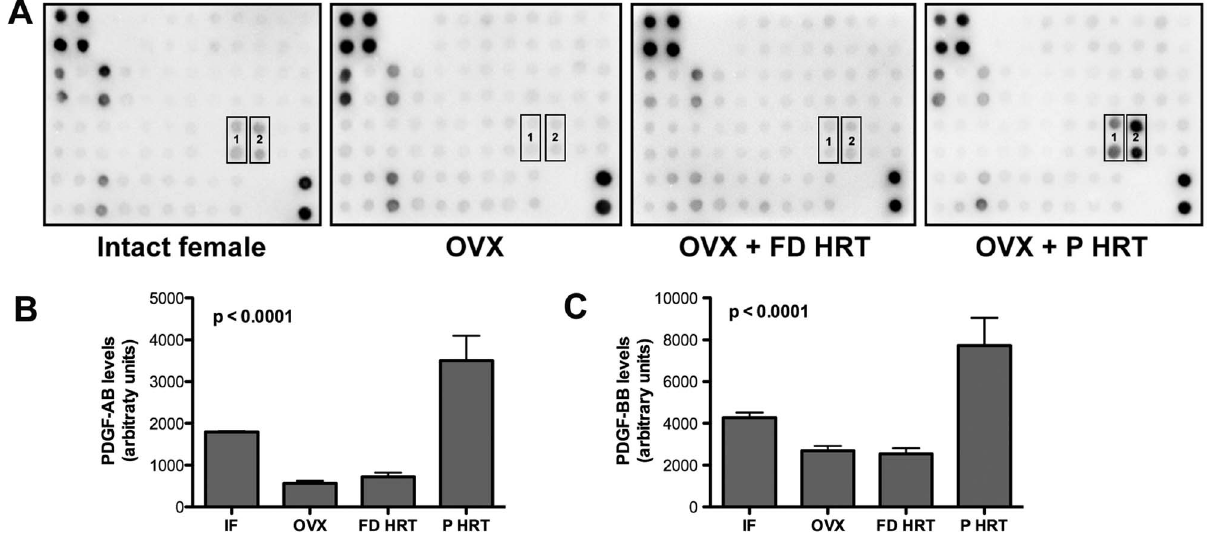
Figure 4. Changes in PDGF-AB and -BB serum levels following OVX and different HRT regimens. Representative images of antibody array analysis of 41 growth factors and receptors following OVX and different HRT regimens in serum of intact female, OVX, OVX + FD HRT, and OVX + P HRT animals (4 samples were analyzed for each group) are shown in A. Two months post OVX, levels of PDGF-AB and -BB (boxes 1 and 2 on antibody arrays respectively) consistently exhibit dynamics correlated with changes in the status of meningeal microvessels (decreased in OVX animals compared to intact females, not corrected by FD HRT, and normalized by P HRT).